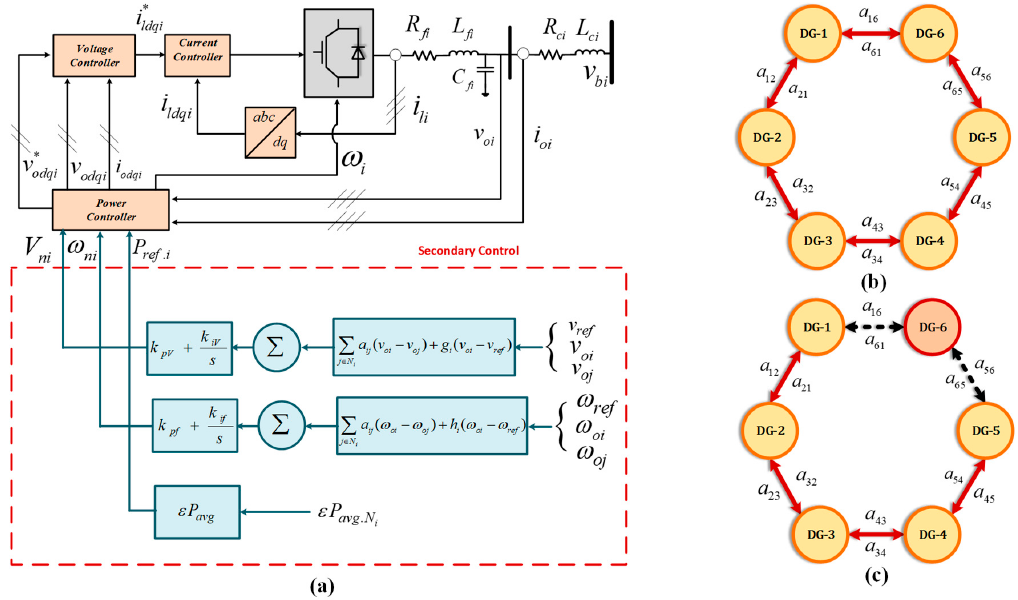
Figure 2. Distributed control scheme: ( a ) Secondary controls at every node ( b ) Full bi-directional connected ring communication network ( c ) Ring communication network with isolated dual link latencies.